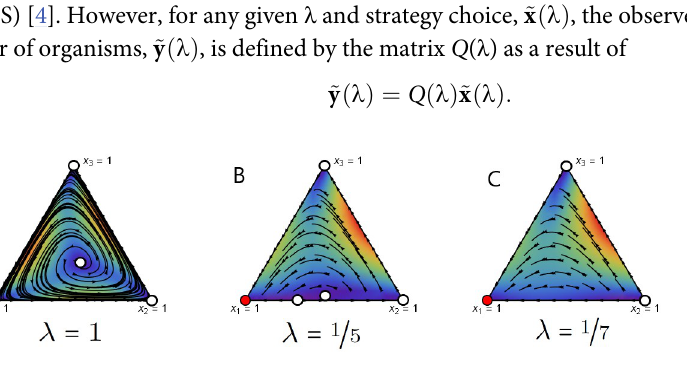
Fig 2. Game flow for the unstable RPS game with uniform mixed strategies for different values of λ . Here, a stable fixed point is denoted by a red circle and a unstable fixed point is denoted by a white circle. The colour in the interior of the simplex indicates the rate of change: from slow (blue) to fast (red). In this example, completely random execution errors lead to the dominance of the rock strategy. We use the Wolfram Mathematica project [49] to produce these phase